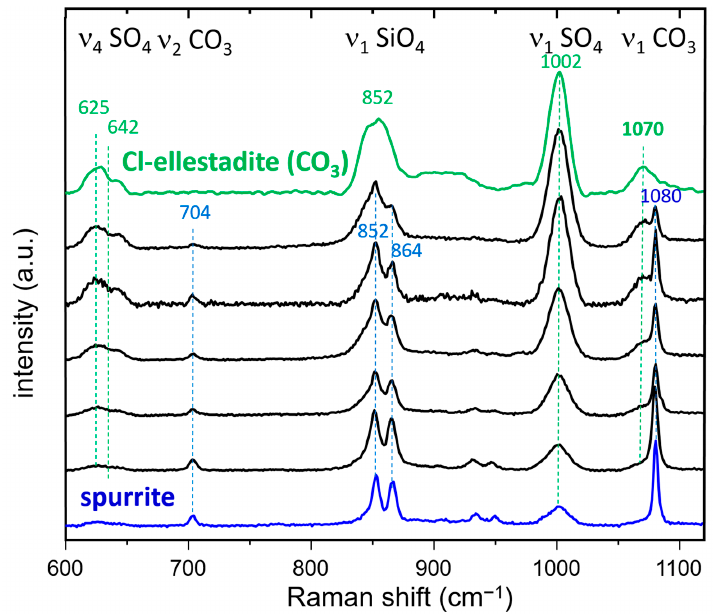
Figure 8. Selected Raman spectra of HT[D2]_800 presenting different degrees of intermixing between spurrite (bottom) and CO 3 -ellestadite (top). It was possible to obtain pure basis spectra for calcite and ellestadite (Figure 9). How- ever, it was not possible to obtain spectra for spurrite free of a sulfate band. Two main observations can be made: The ν 1 CO 3 stretching vibration of calcite and spurrite give rise to bands at 1086 and 1080 cm − 1 , respectively. The ν 2 CO 3 vibration results in bands at 712 and 704 cm − 1 , correspondingly. Thus, the contributions of calcite and spurrite in the mixed spectrum could be unambiguously differentiated.